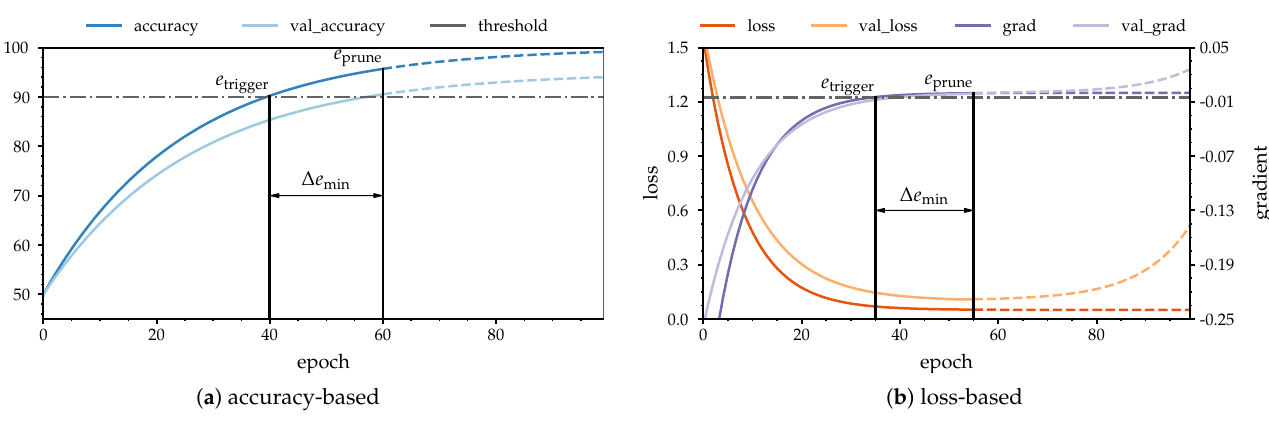
Figure 4. Implemented triggers for the feature selection callback applied in a fictional optimization process. The dashed lines indicate the hypothetical trend of each accuracy value after the pruning; ( a ) visualization of the accuracy-based case and ( b ) the loss-based